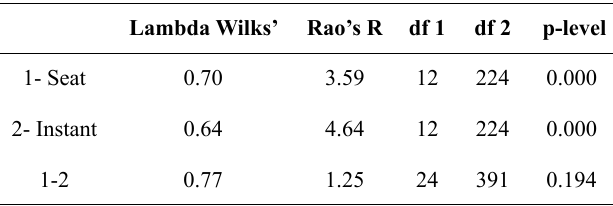
Table 1 - Summary of all effects (seat x